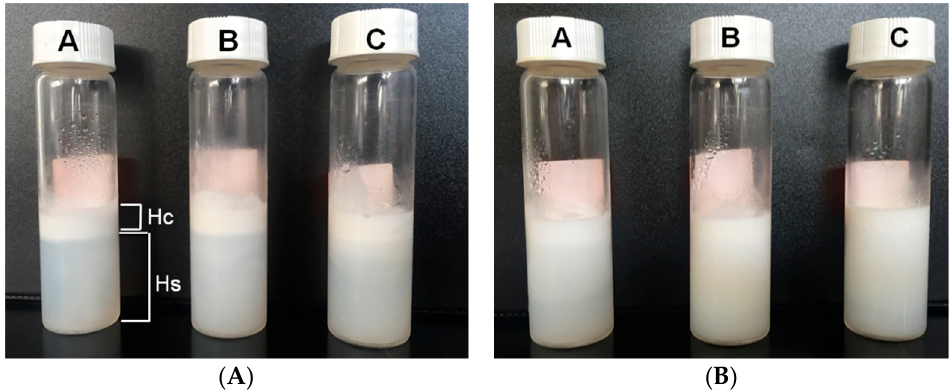
Figure 6. Phase separation images of AL-CS nanoemulsions (A: soybean oil, B: sacha inchi oil, C: olive oil) prepared with different surfactant concentrations, that is, ( A ) 0.1% and ( B ) 0.5%. The samples were stored for six months at 5 °C.